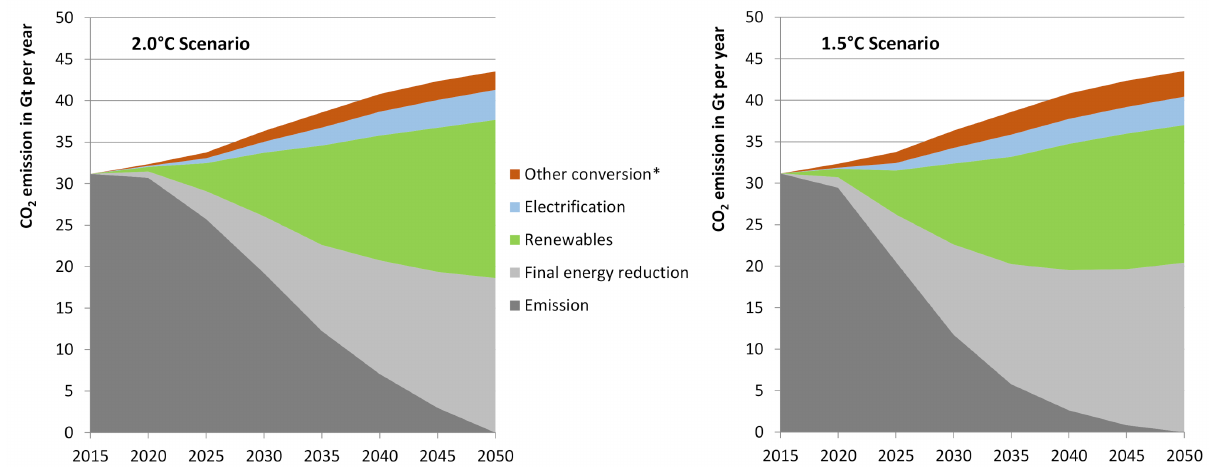
Figure 3. Annual CO 2 emissions reductions in the 2.0 ◦ C (left) and 1.5 ◦ C Scenarios (right) in relation to the 5 ◦ C (REF) Scenario according to the measures implemented. Renewable energies and efficiency measures (including efficiency improvements through electrification) are roughly equally important in all the scenarios. Reduced consumption has an even greater role in the 1.5 ◦ C Scenario. Other conversions (*) include changes in district heating, refineries, coal transformation, and gas